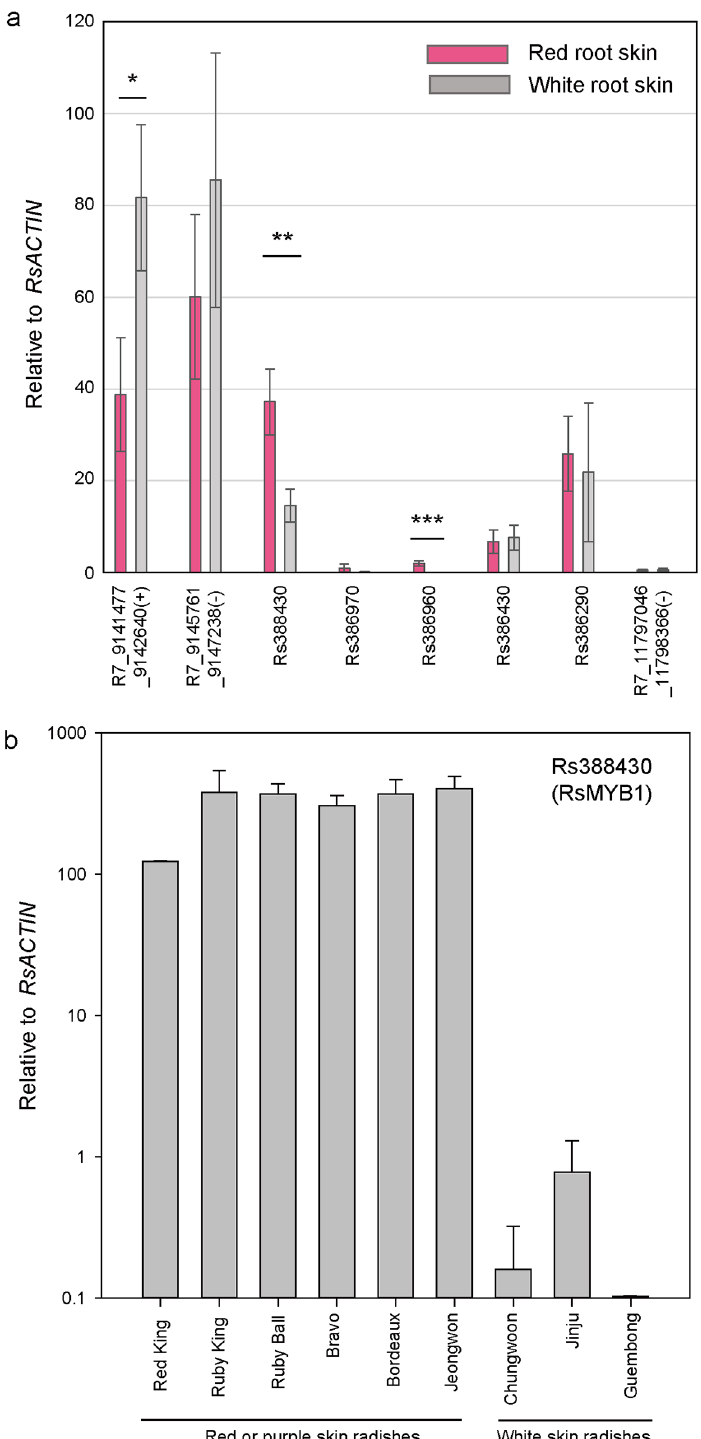
Fig 4. Transcription levels of RsMyb1 and other candidate genes in red and white root skins. (a) Transcription levels were measured by qRT-PCR and presented relative to RsACTIN . Positions on chromosome R7 and predicted functions of the genes are as follows: R7_9141477_9142640 ( + ) (binding partner of ACD11 1-like), R7_9145761_9147238 ( - ) (heat stress transcription factor A-8), Rs388430 (R7_9348525_9349979(+), transcription factor MYB114-like) Rs386970 (R7_10205078_10206725(-), isoflavone reductase homolog P3),